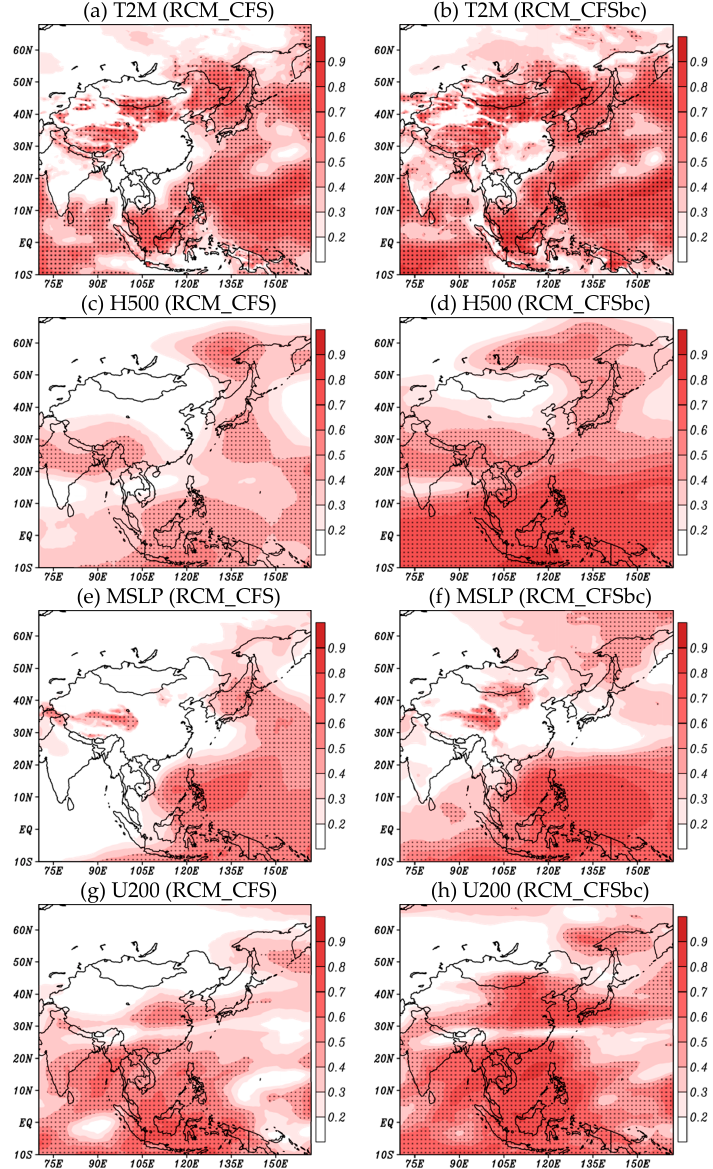
Figure 5. Temporal correlation of ( a )–( b ) 2 m temperature, ( c )–( d ) 500 hPa geopotential height, ( e )–( f ) mean sea level pressure, and ( g )–( h ) 200 hPa zonal wind between RCM_R2 and RCM_CFS (left) and RCM_CFSbc (right) during the 1982–2006 winter season. Stippled areas indicate significance at the 95% confidence level.